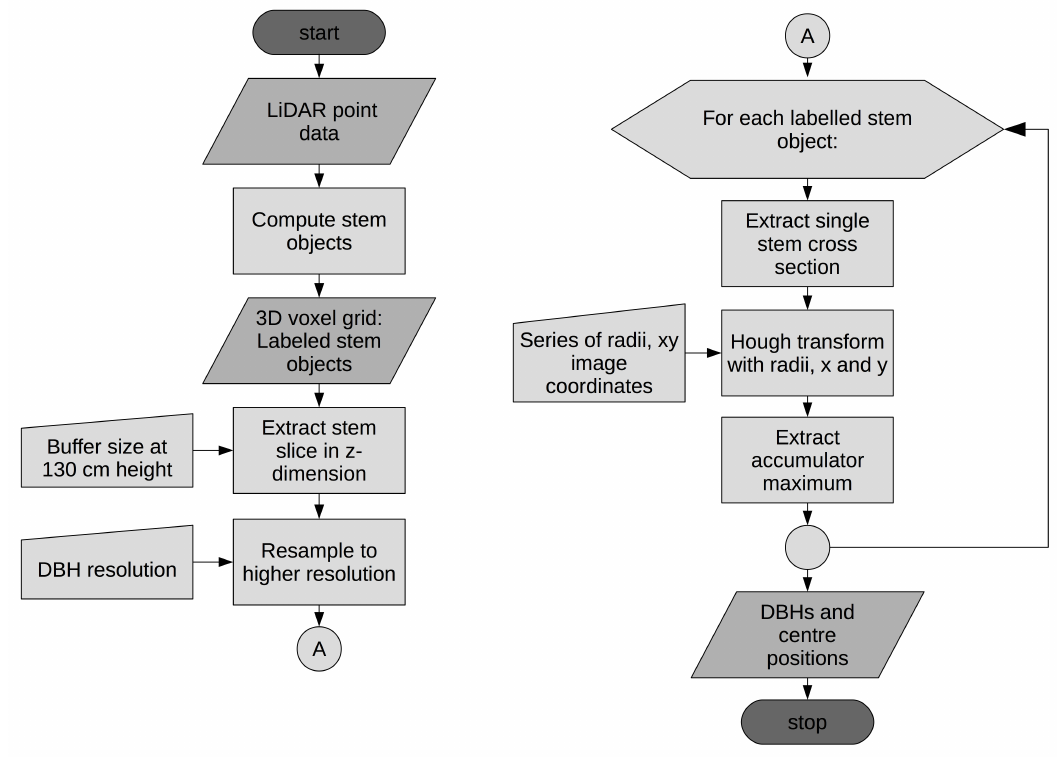
Figure 1. Flowchart for estimating DBH from isolated 3D tree stem